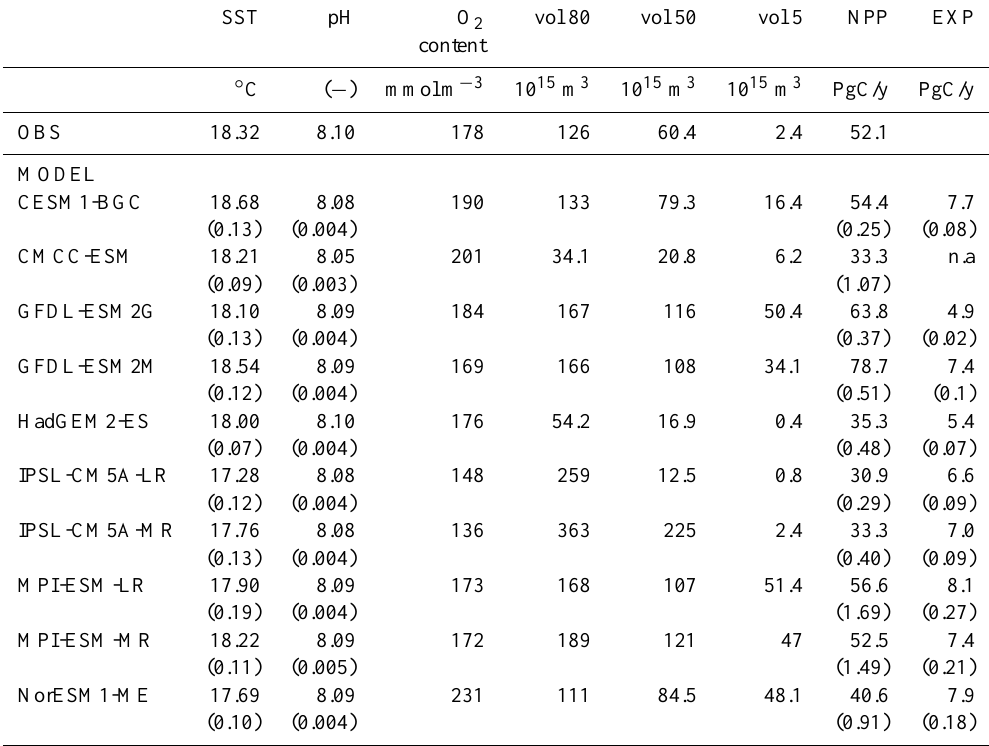
Table 2. Observed and modeled present-day global average of sea surface temperature ( ◦ C), surface pH (pH unit), dissolved oxygen (mmolm − 3 ) , volumes of waters (10 15 m 3 ) in which O 2 is less than 80, 50 and 5mmolm − 3 , net primary productivity (PgCyr − 1 ) and export production of organic particles at 100m (PgCyr − 1 ) . Interannual standard deviations, when meaningful, are also indicated in parenthe- sis. Observed estimates are from Reynolds et al. (2008) for SST, computed using DIC and alkalinity from Key et al. (2004) for surface pH, from WOA (2009) for O 2 content, from Bianchi et al. (2012) for the volumes of low oxygen waters, from Behrenfeld et al. (1997) for NPP. All data are from 1990–1999 except satellite-derived NPP from 1997–2006, and oxygen quantities from climatologies (n.a. = not